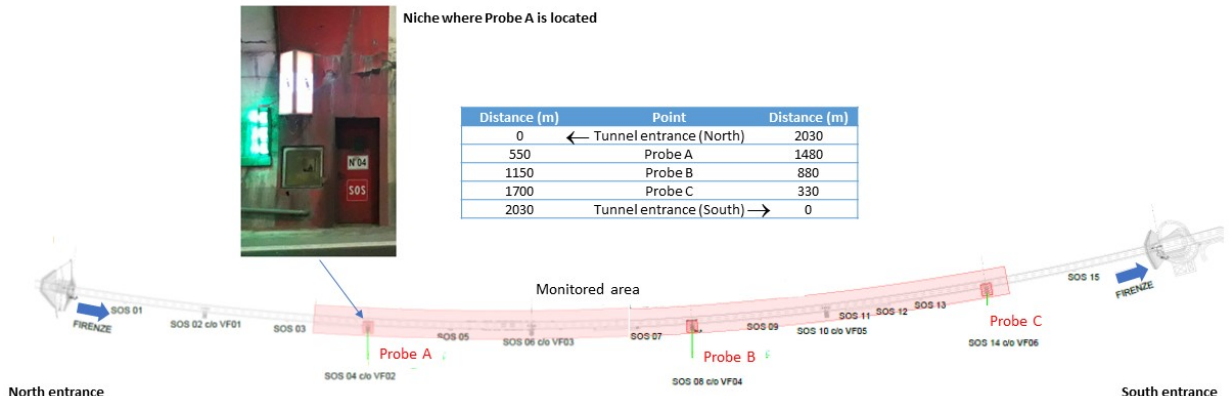
Figure 6. Schematic of the Manganaccia Tunnel close to Florence, Italy.